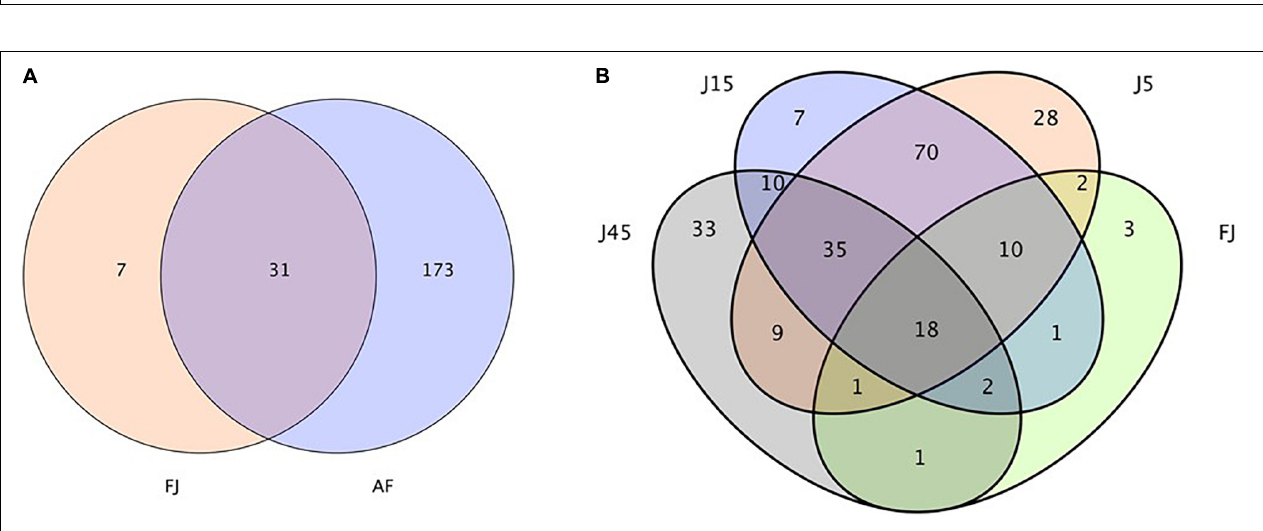
FIGURE 2 | (A) Diagram of the operational taxonomic units between the AF, fresh lucerne and FJ, pre-fermented juice. (B) Venn analysis for operational taxonomic units FJ and J, pre-fermented juice-treated silage.